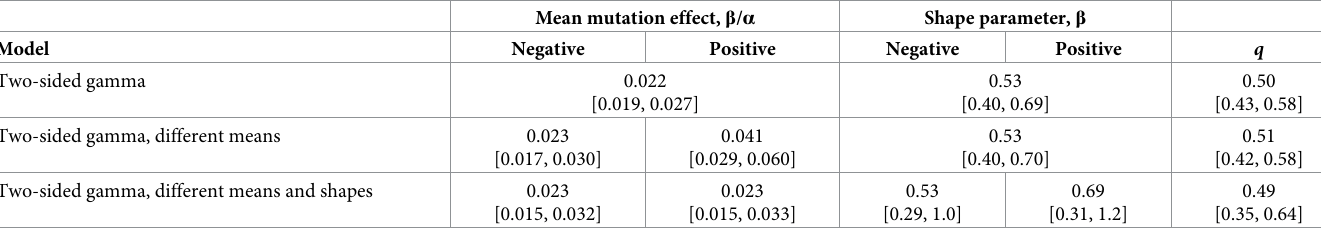
Table 4. Models, and parameter estimates. 95% credible intervals are shown in square